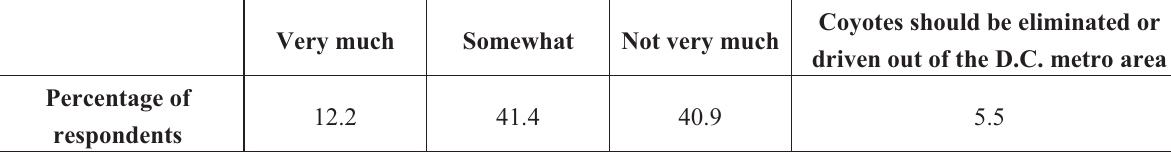
Table 1. Responses to the question: “How much do you support the existence of coyotes in the D.C. metro area?” N = 763. Given in percentages.